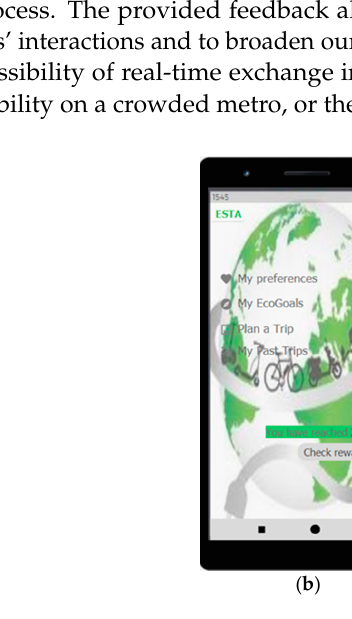
Figure 2. ( a ) Welcome Screen integrating social reinforcement and recognition; ( b ) Home Screen integrating options for personalization, challenges and goal setting, recognition and cause-and-effect simulation.